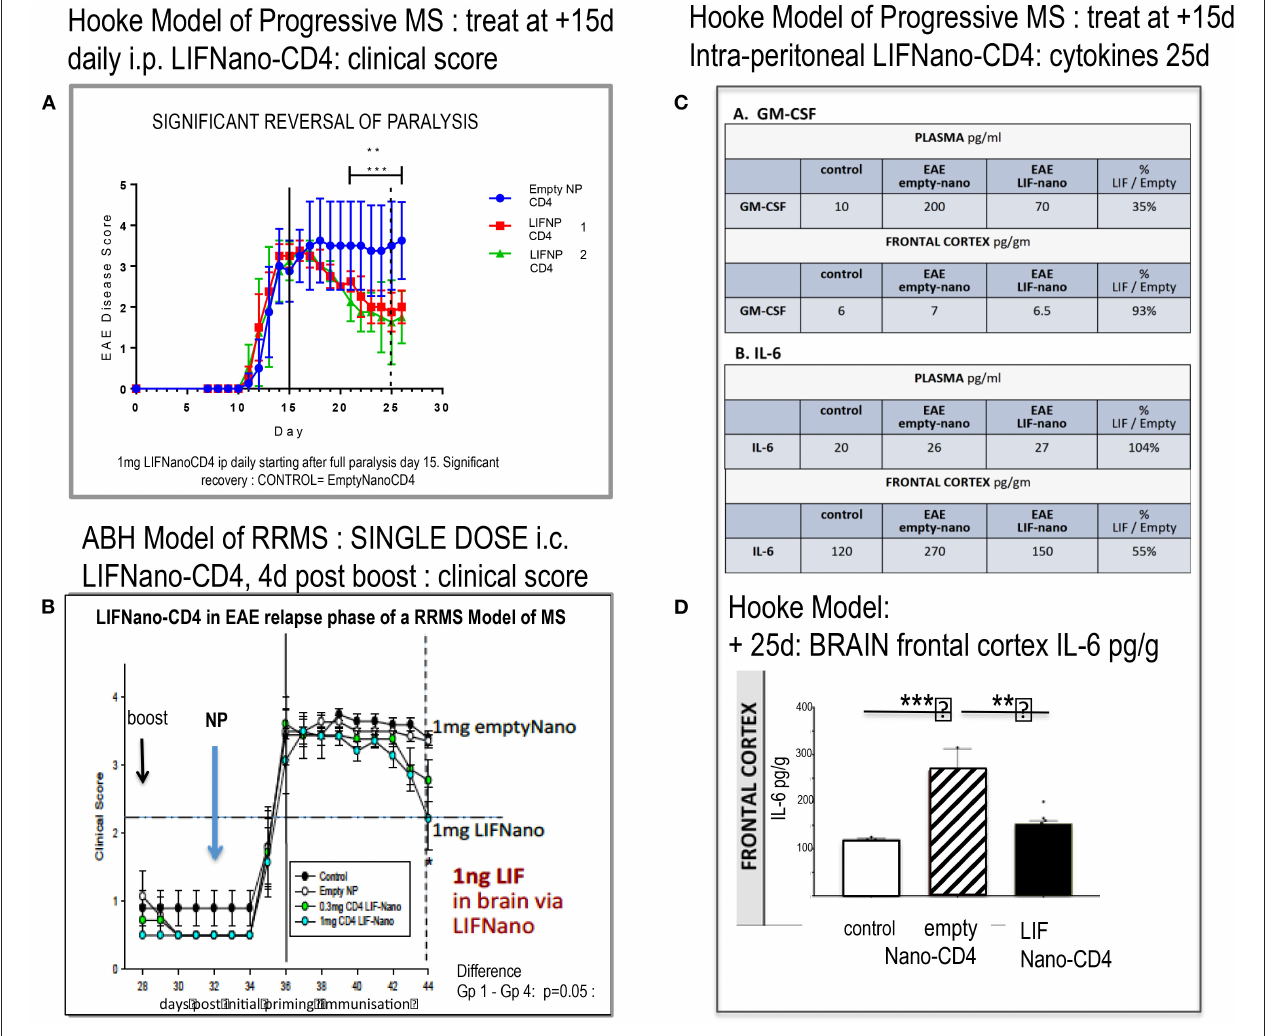
FIGURE 3 | Effect of LIFNano-CD4 in two mouse models of EAE. (A) The Hooke model of progressive MS as described in the text and (B) the Biozzi model of relapsing–remitting MS (RRMS) used to test for neuro-protective efficacy as detailed in Al-Izki et al. ( 7). Briefly, Biozzi ABH are immunized using spinal cord homogenate plus adjuvant to induce first relapse measured by clinical score. Following spontaneous recovery, primed mice receive a boost immunization (28 d) followed by LIFNano-CD4 (32 d) prior to onset of second relapse. Clinical scores were continued out to 44 d. (C) Mice from (A) were culled and cytokines measured (see Supplementary Material ). The table (C) shows GM-CSF and IL-6 cytokine responses in plasma and brain at 25 d, where treatment was given daily 15–24 d as detailed in the text. (D) Histogram of IL-6 levels in the brain frontal cortex of controls (open), EAE (Hooke) treated with empty Nano-CD4 (diagonal), and EAE (Hooke) treated with LIFNano-CD4 (black). Statistical Significance *** > 0.001; ** > 0.01. Full multiplex data is provided in Supplementary Material